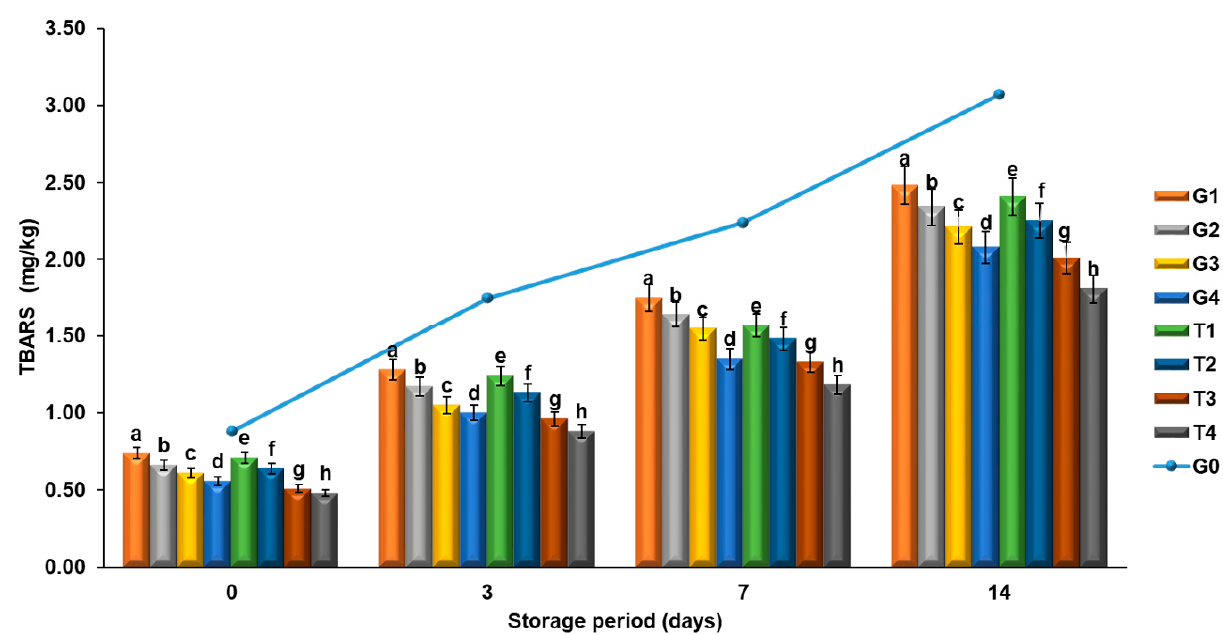
Figure 4. Changes in TBARS of meatballs during storage. The results are expressed as mean ± standard error. a–h For each day, columns representing different values are labeled with different letters.